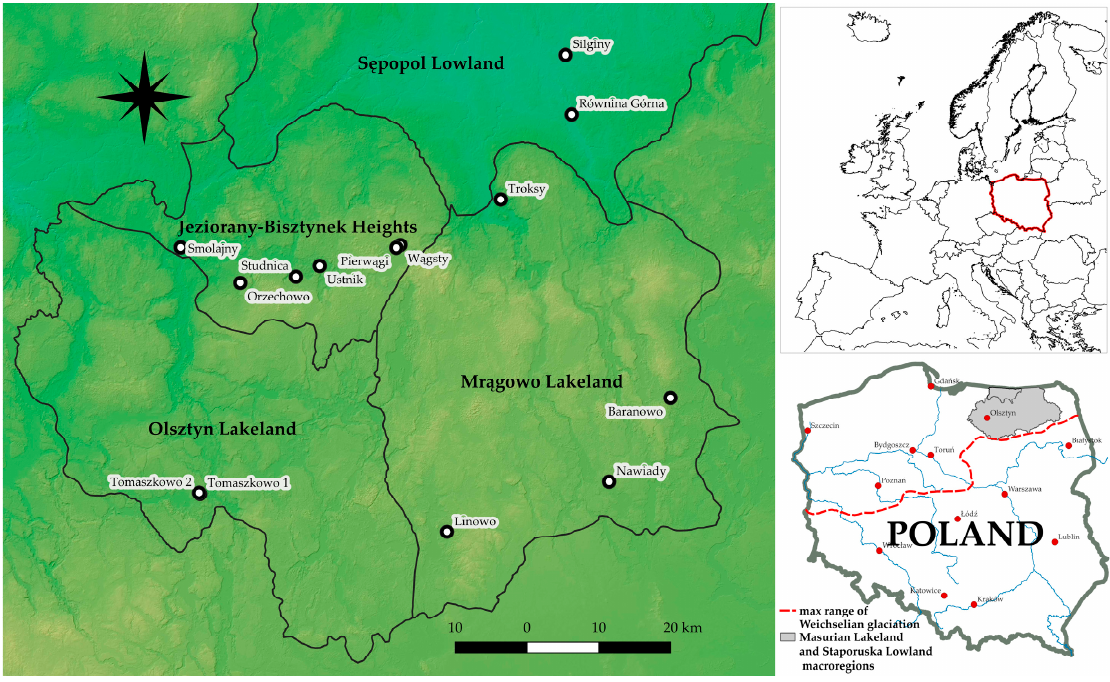
Figure 1. Location of the soil catenas.